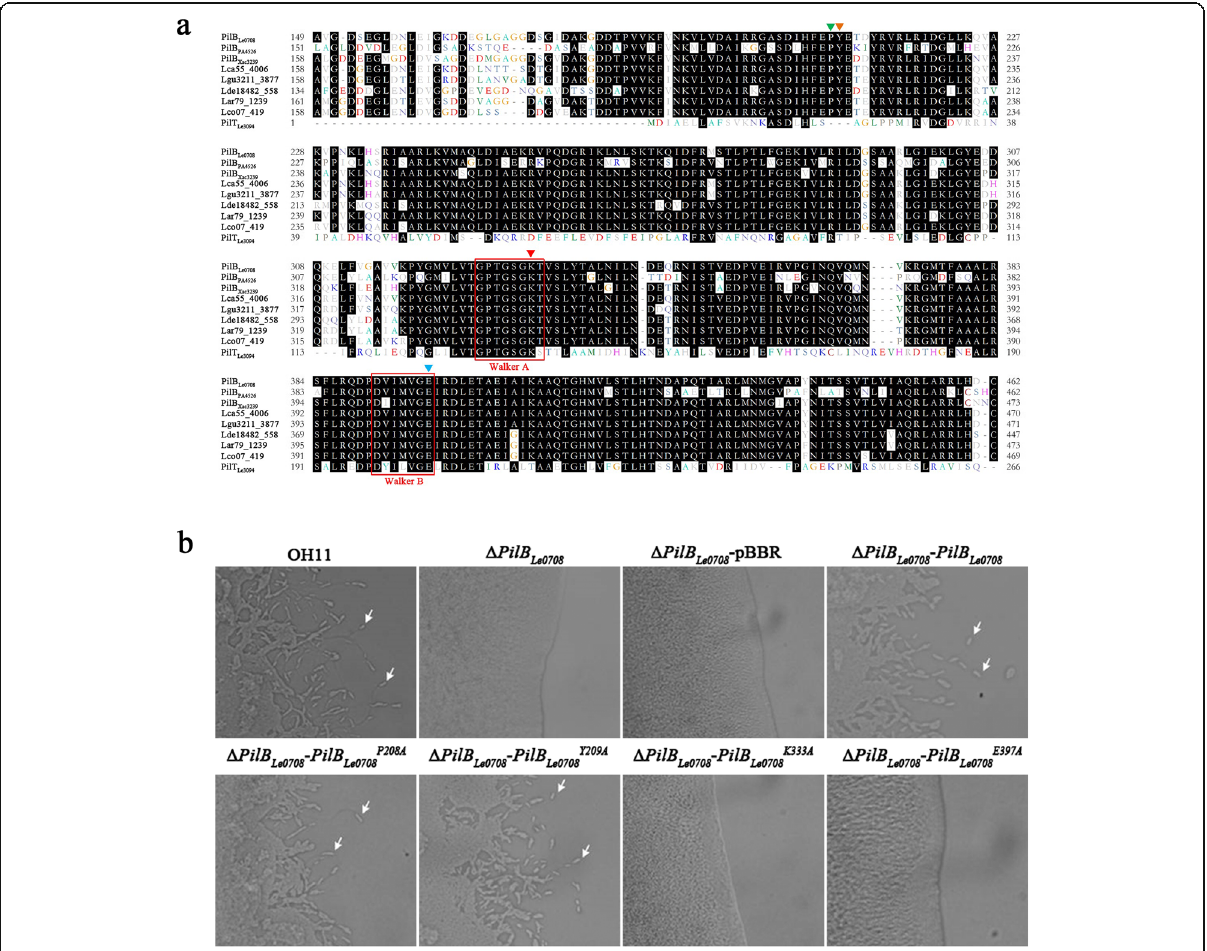
Fig. 4 The K333 and E397 residues were required for the regulation of PilB Le0708 in the formation of twitching motility in L. enzymogenes OH11. a Multiple sequence alignment of the